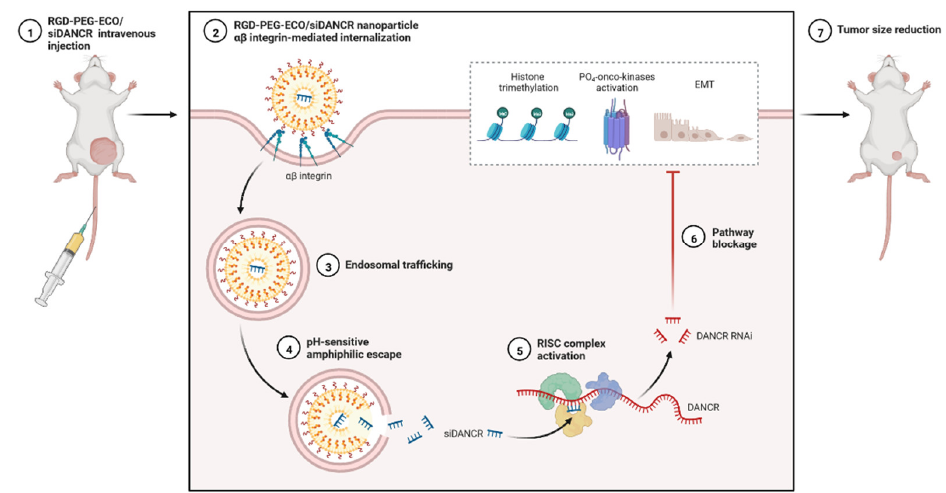
Figure 7. Expression analysis of RGD-PEG-ECO/siDANCR nanoparticles in an animal model of TNBC.